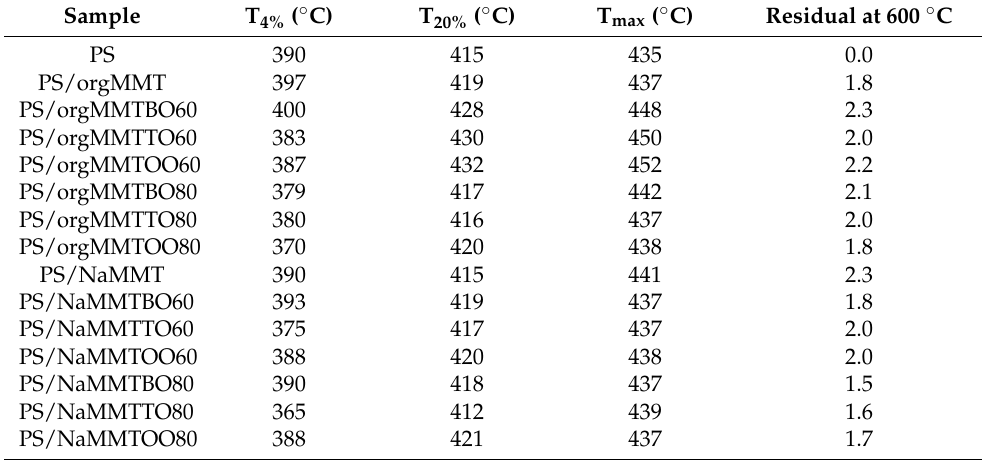
Table 4. TGA data of neat PS and its nanocomposites with the sodium and orgno-modified MMT with or without the essential oils. Temperatures at 4% and 20% degradation, as well as at the maximum degradation rate, T 4% , T 20% and T max and residual mass at 600 ◦